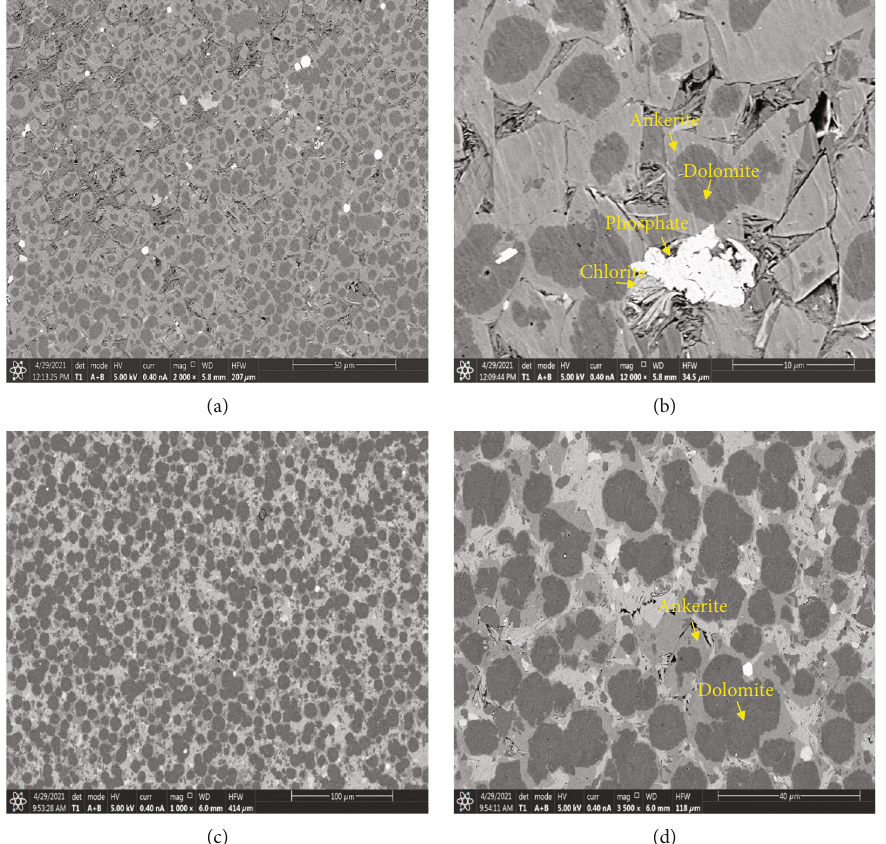
Figure 5: SEM images of the core (a, b) and rim (c, d) areas within dolomite nodule. Dolomite crystals in the core area are more ephedra than those in the